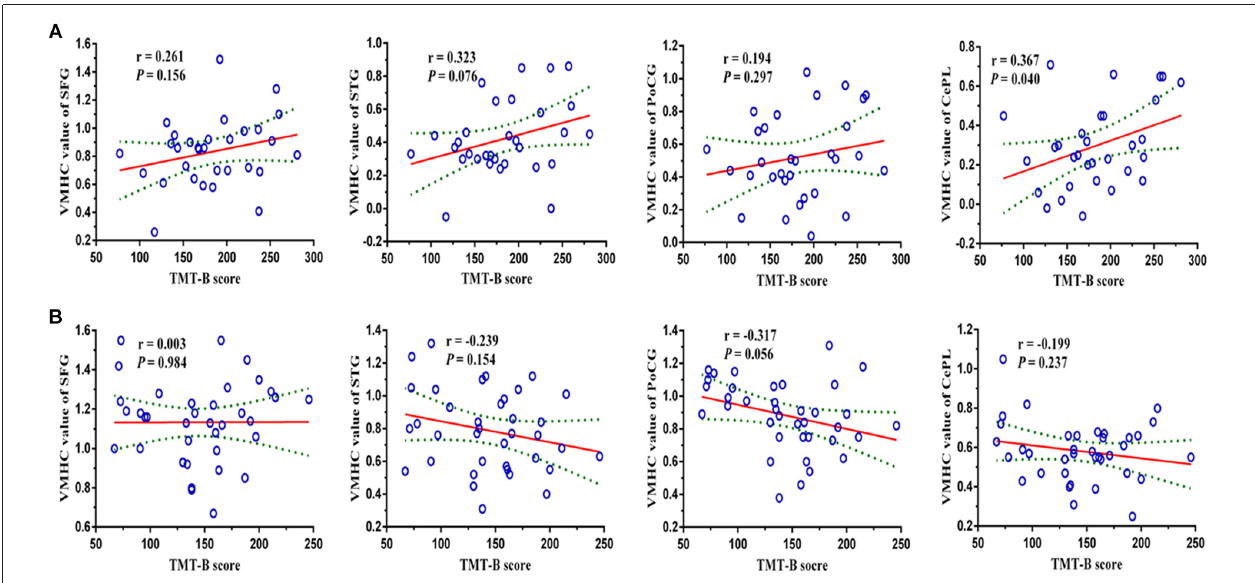
FIGURE 3 | Pearson’s correlation analysis revealed that the reduced VMHC strength in bilateral CePL was positively correlated with the performance of TMT-B in LOD ( r = 0.367, P = 0.040). Notes: VMHC, Voxel-Mirrored Homotopic Connectivity; SFG, Superior Frontal Gyrus; STG, Superior Temporal Gyrus; PoCG, Postcentral Gyrus; CePL, Posterior Cerebellar Lobe; TMT-B, Trail Making Test B; LOD, Late-Onset Depression. The figures of row (A,B) represent the relationships (TMT-B and regional VMHC values) in LOD and HCs, respectively.